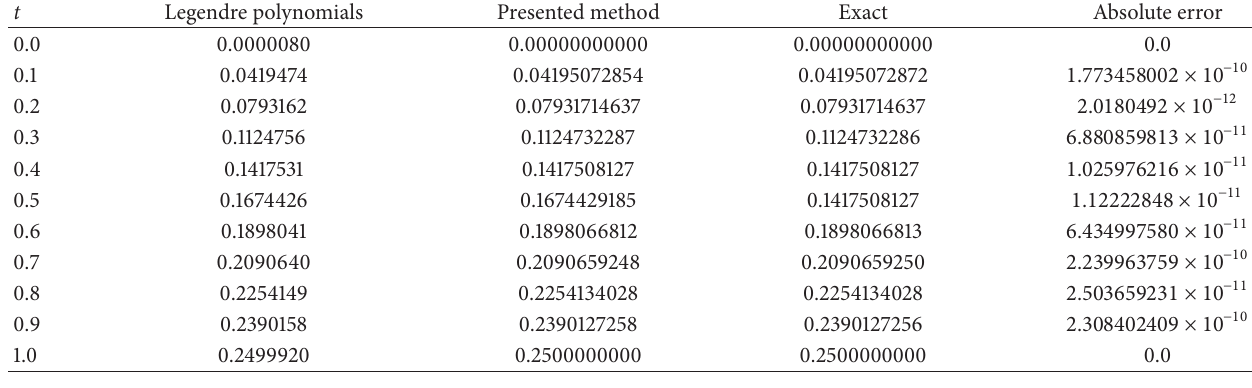
Table 1: Legendre polynomials, presented method, exact, and absolute error of 𝑦(𝑡) for Example 3.